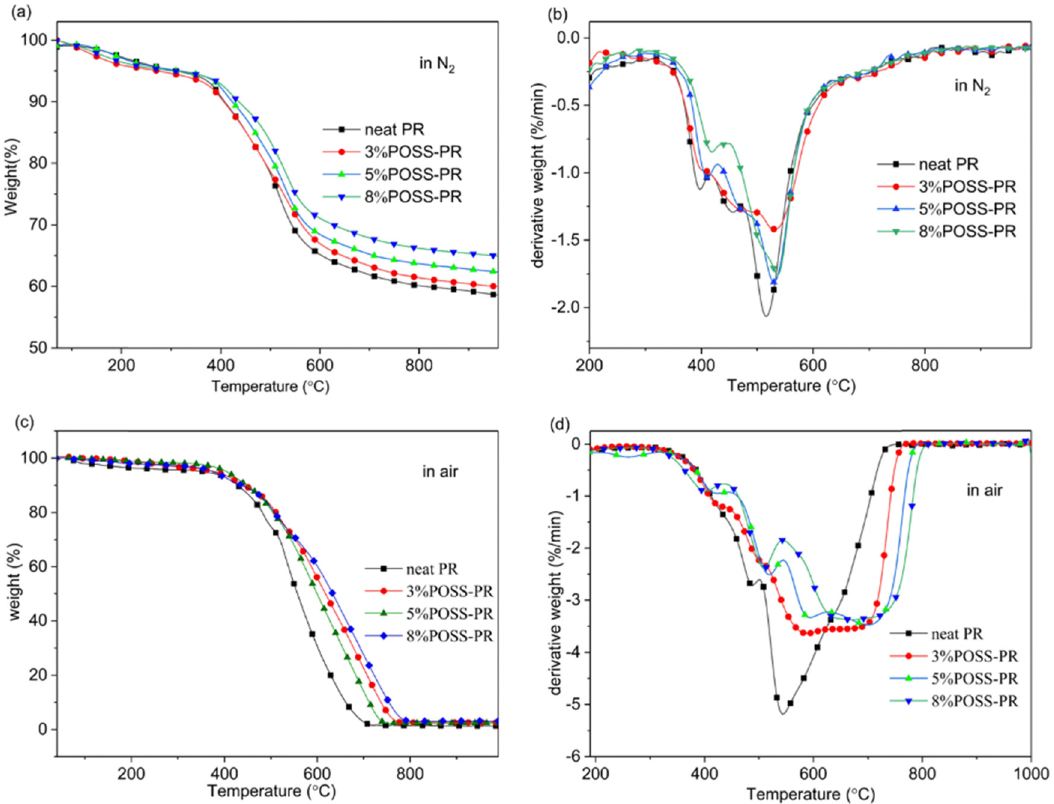
Figure 9: TG and DTG curves of PR and POSS - PR: ( a and c ) weight - temperature curve ( TG ) , ( b and d ) derivative weight - temperature curve ( DTG )